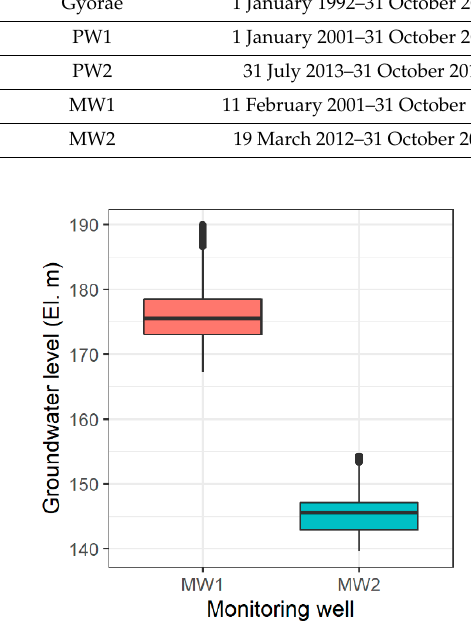
Figure 3. Boxplot for the variability of groundwater level in monitoring wells.